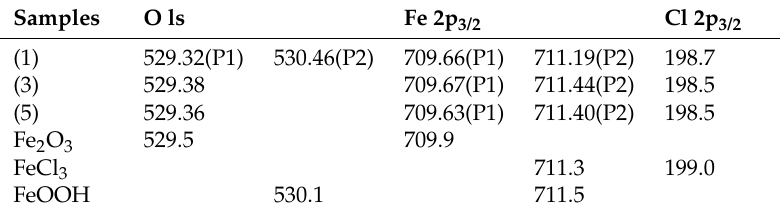
Table 3. Binding energies data from XPS (eV) for elements present in samples (1), (3), and